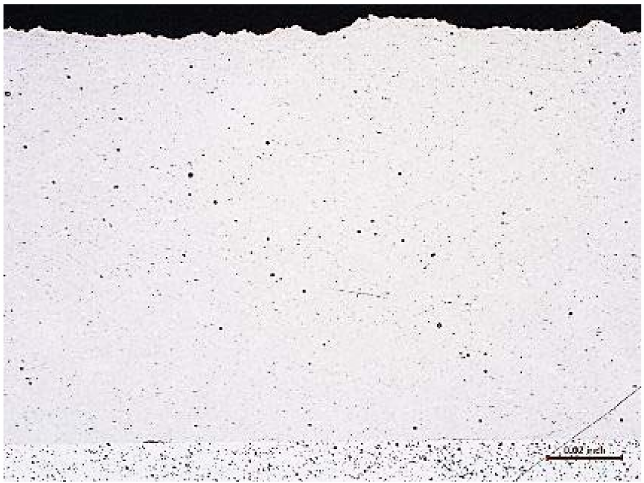
Figure 7. Micrograph depicting typical microstructure observed on aluminium 2024 cold-sprayed coating on aluminium 2024 substrate. As-etched; At 25 × .